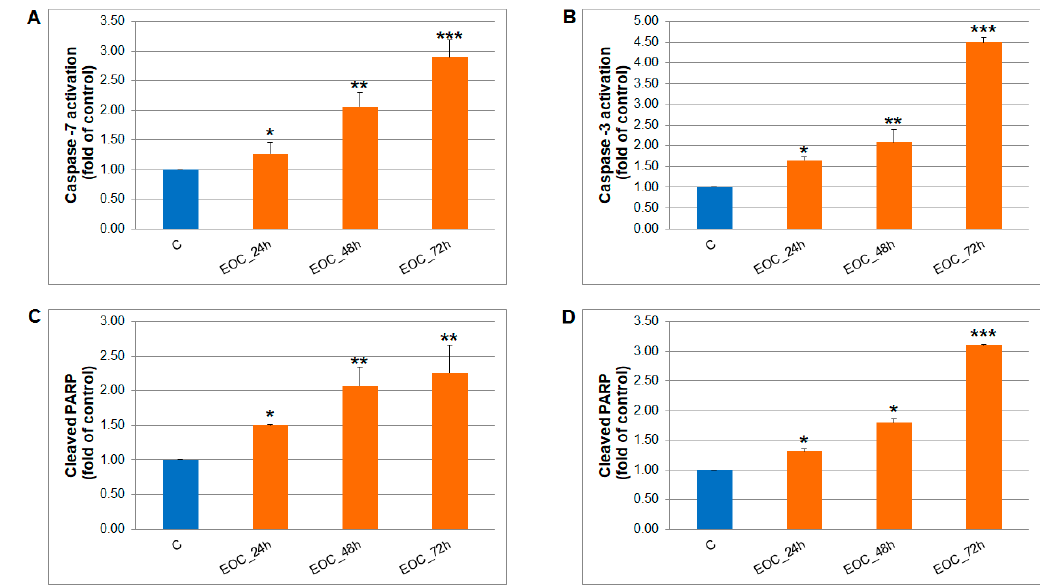
Figure 12. Effect of EOC treatment (1:25,000, 1:65,000) on: A ) caspase-7 (MCF-7), B ) caspase-3 activation (MDA-MB-231) and PARP cleavage in both cell lines ( C , MCF-7 cells; D , MDA-MB-231 cells) analyzed by flow cytometry. Data were obtained from three independent experiments and significant differences were marked as p < 0.05 (*), p < 0.01 (**), p < 0.001 (***) vs. control cells (untreated).